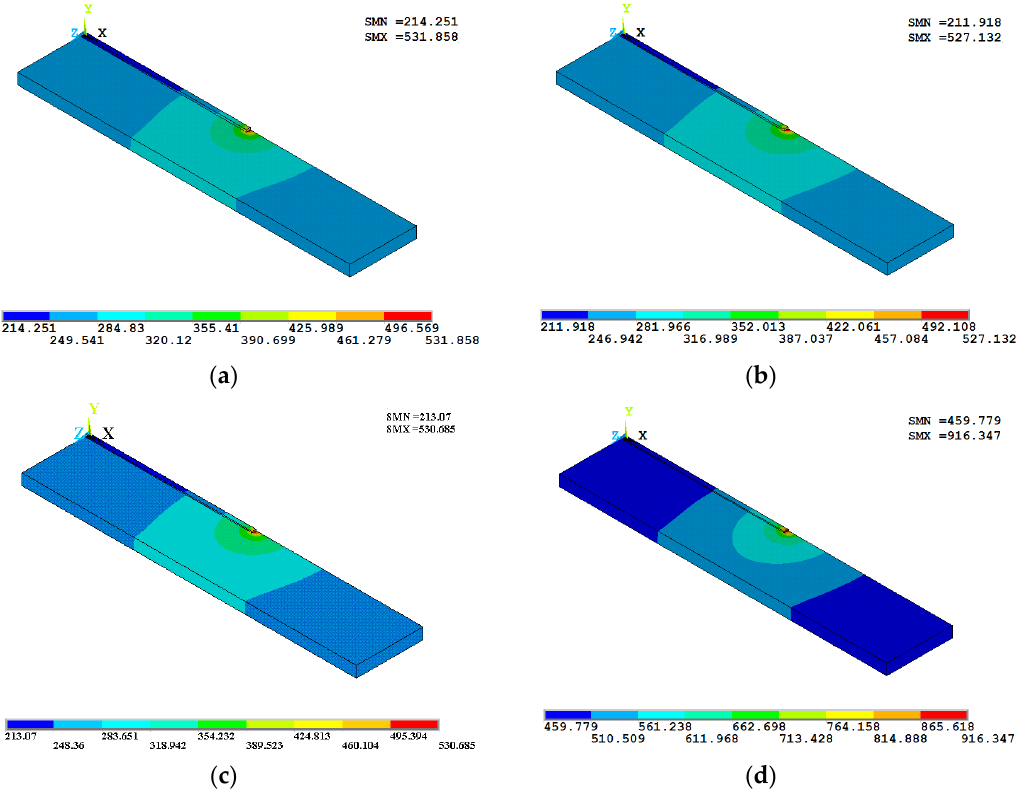
Figure 6. Temperature distributions when the weld gun travels to the midpoint of the first layer with travel speed ( a ) v T = 0.15 m/min; ( b ) v T = 0.20 m/min; ( c ) v T = 0.25 m/min and ( d ) v T = 0.30 m/min.